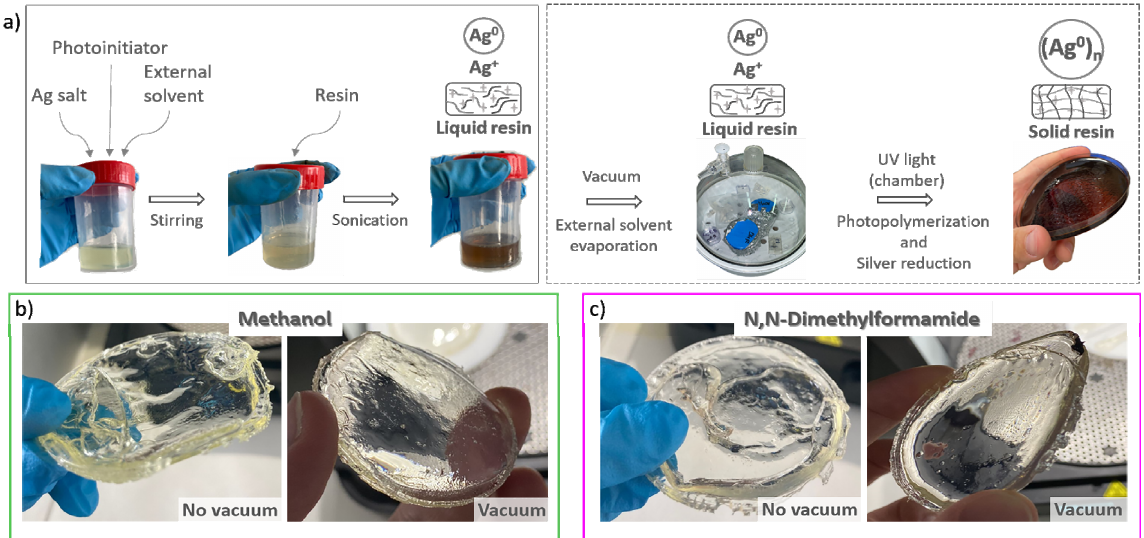
Figure 1. ( a ) Scheme representation of the preparation method of the 3D nanocomposites using a UV chamber; solid disks obtained from the solutions of acrylic resin containing methanol ( b ) and DMF ( c ) without (left) and with (right) the vacuum step added to the synthesis.